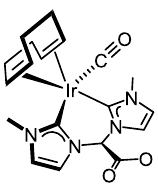
Figure 5. Complex 2